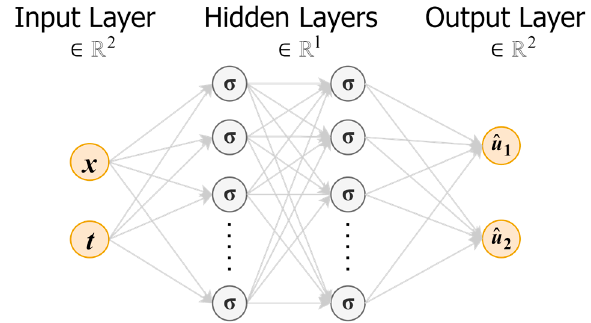
Figure 2. FNN architecture for the implementation of the PINN surrogate model. The FNN consists of the input layer, the hidden layers (composed of weights, 𝑊 ℓ ; biases, 𝑏 ℓ ; and activation function, 𝜎 ), and an output layer.